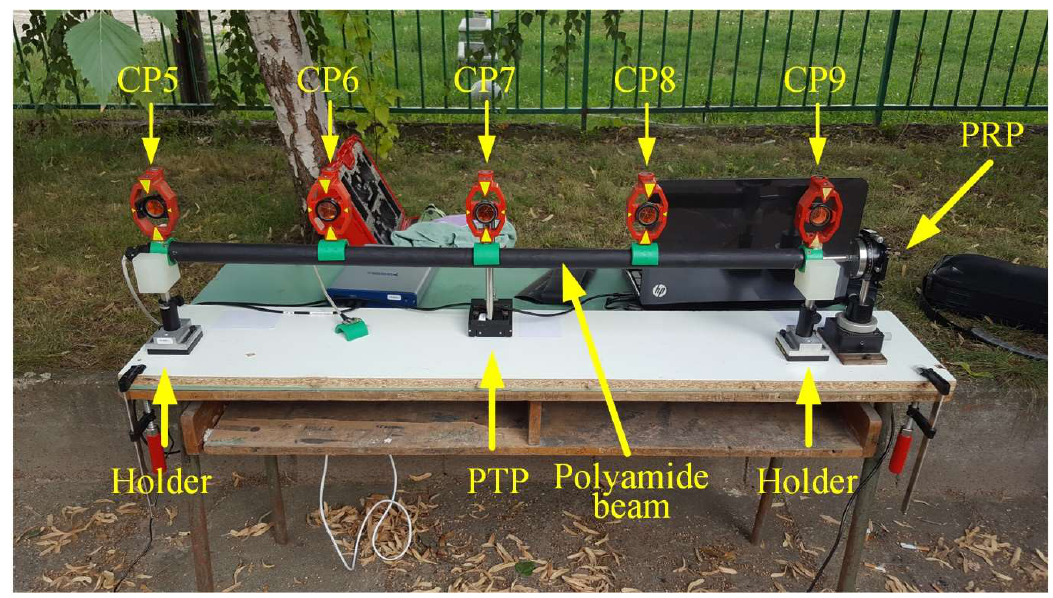
Figure 5. Experimental setup.